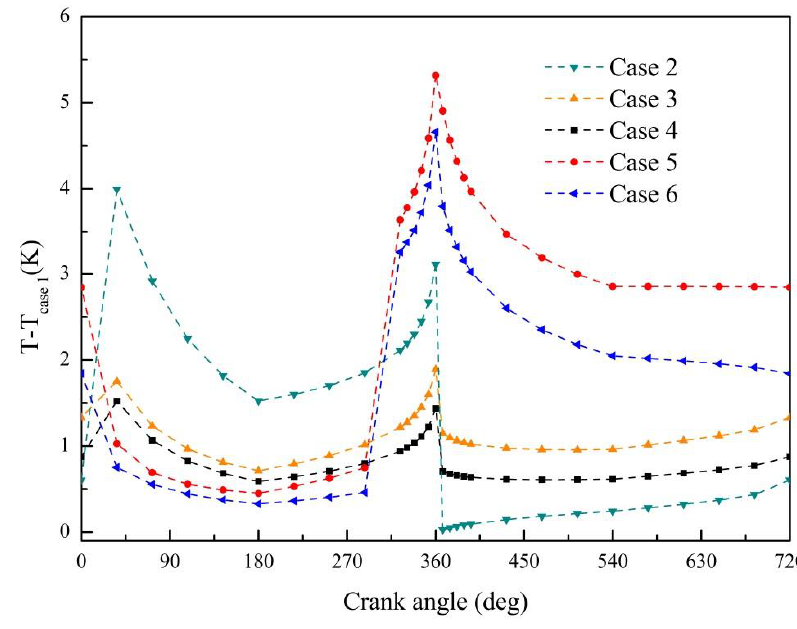
Figure 8. Difference of cylinder gas temperature under different coolant conditions.